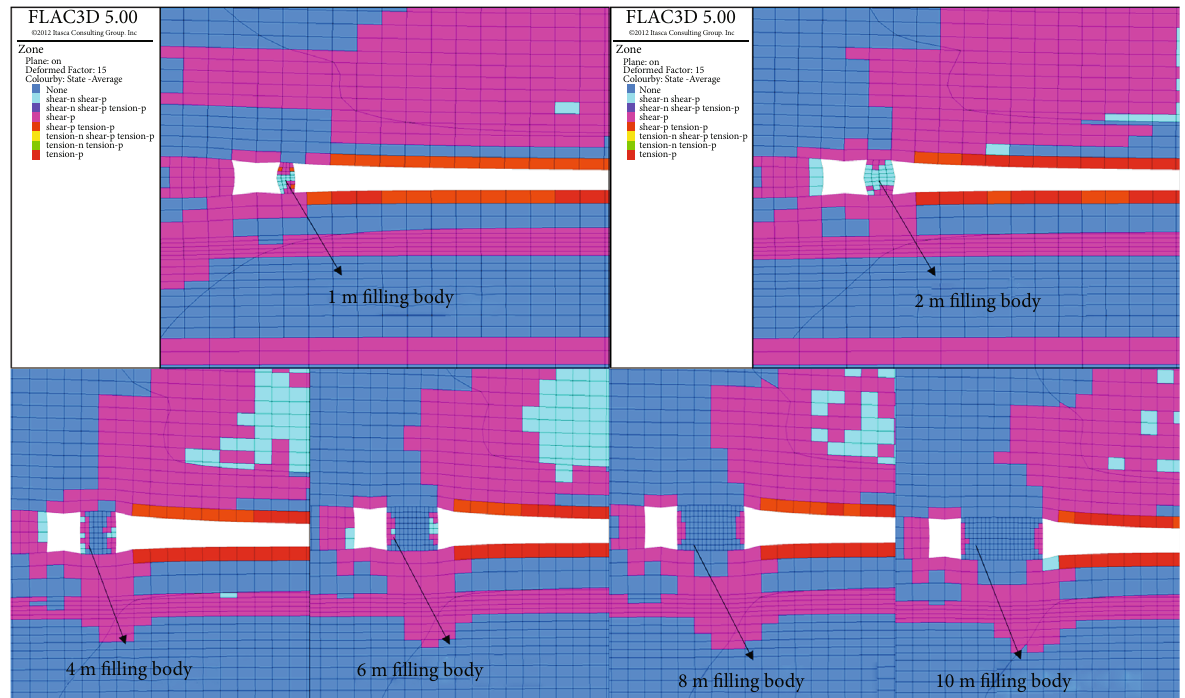
Figure 8: Distribution of plastic zone of di ff erent width fi lling bodies.